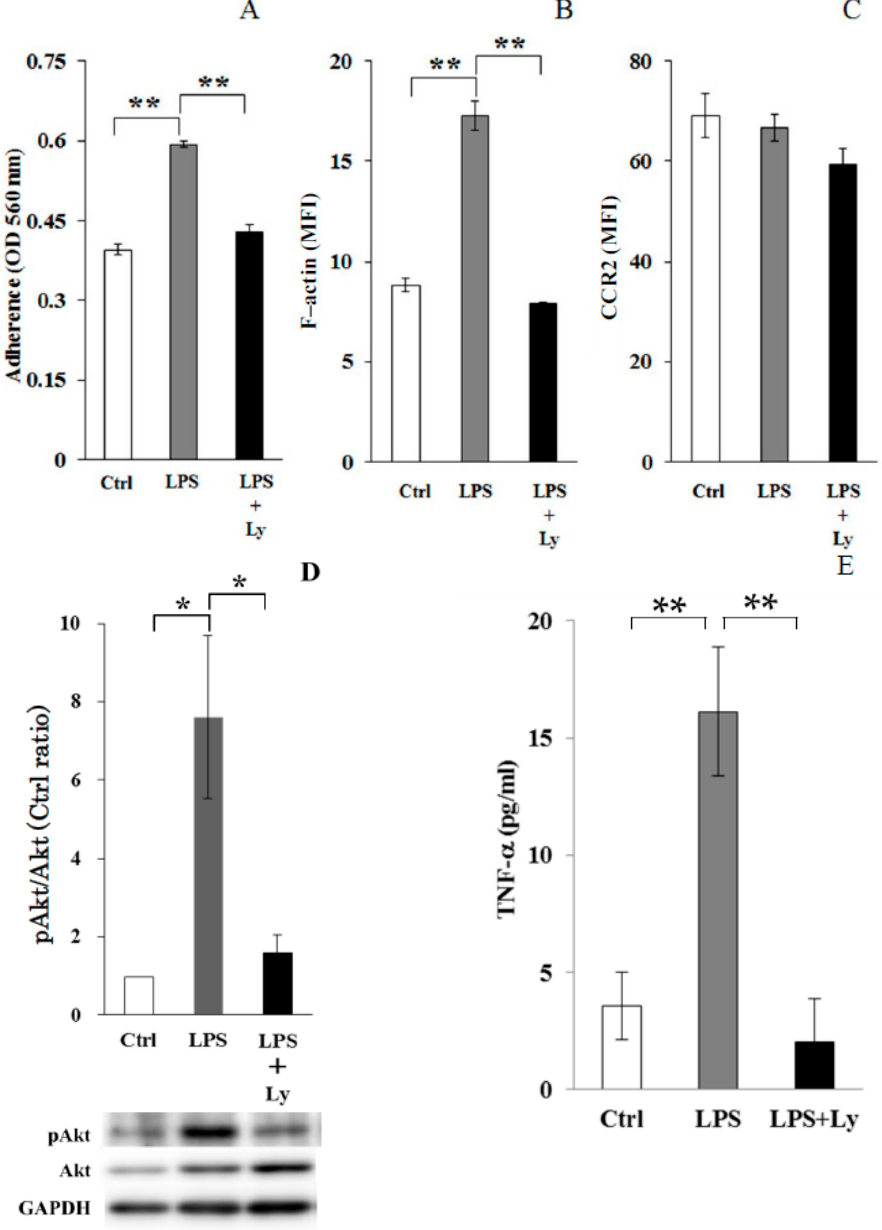
Figure 2. The effect of phosphoinositide 3-kinase (PI3K) inhibitor Ly treatments on cell adherence ( A ), F-actin ( B ), CCR2 ( C ), phosphorylation of Akt proteins ( D ) and TNF- α production ( E ) of J774 cells ( n = 8). * p < 0.05 and ** p < 0.01. Western blot results of phospho-Akt (pAkt)/total Akt. Results were quantitated by densitometry and ratios of pAkt/total Akt were plotted. Y axis is in arbitrary unit (D).